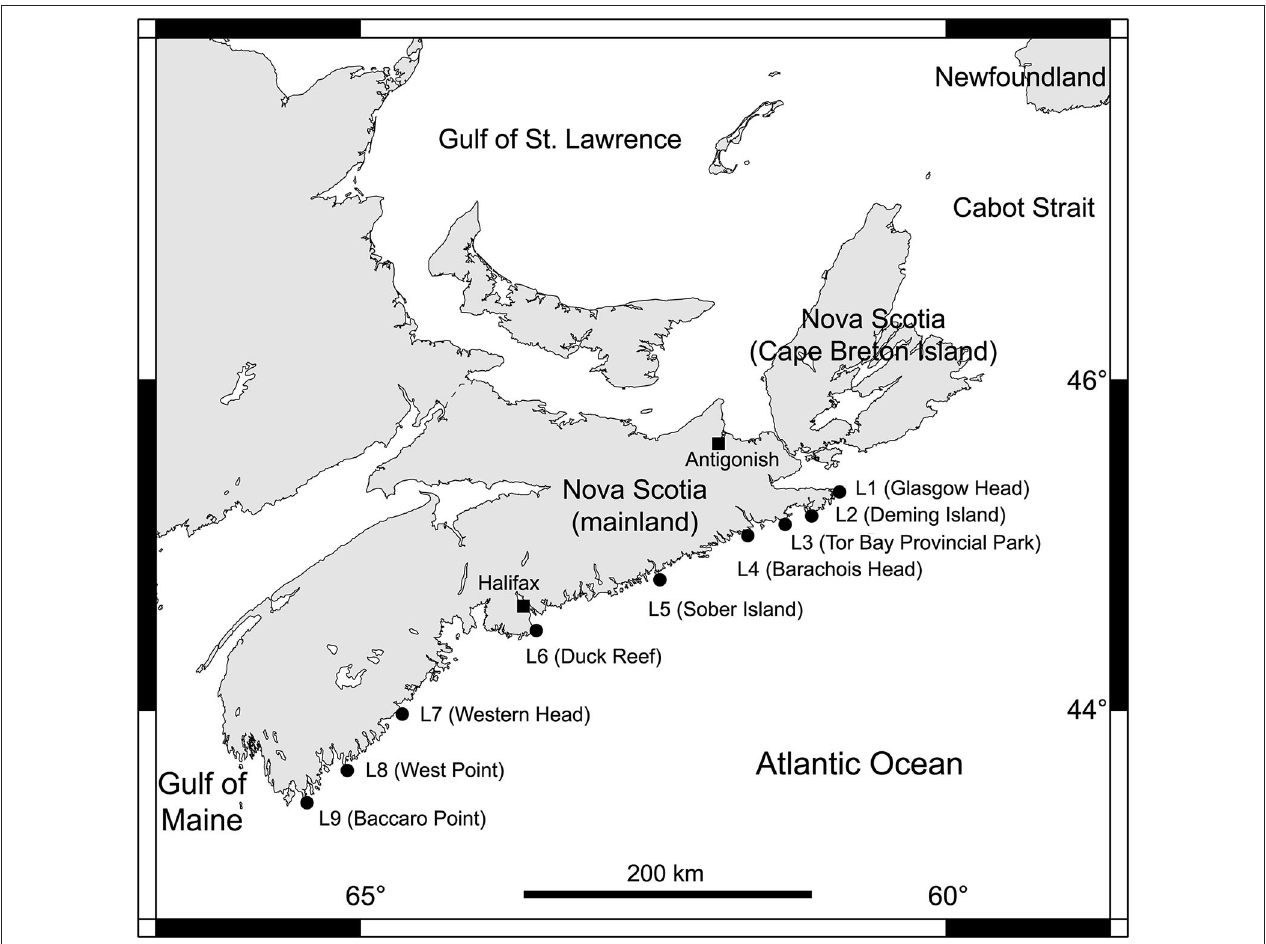
FIGURE 1 | Map indicating the position of the nine wave-exposed intertidal locations surveyed along the Atlantic coast of mainland Nova Scotia, Canada (see section Materials and Methods for their geographic